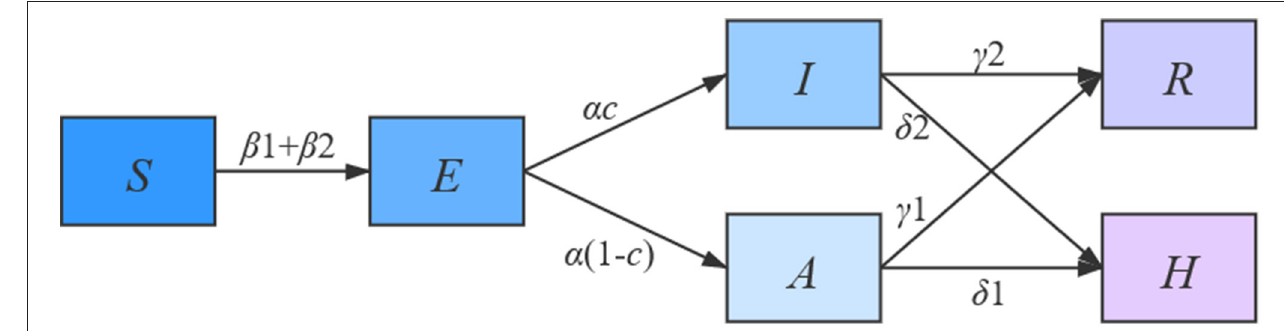
FIGURE 2 | Flow diagram of the SEIARH model.